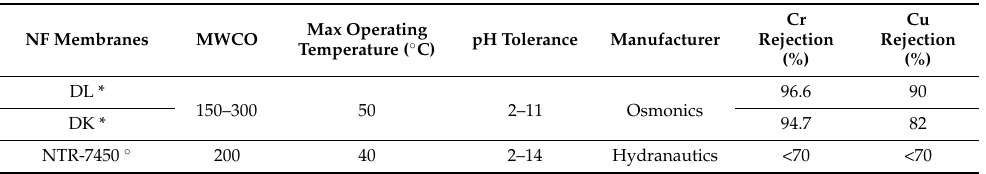
Table 7. Characteristics of the NF commercial membranes, adapted with permission from ref. [59]. Copyright 2021